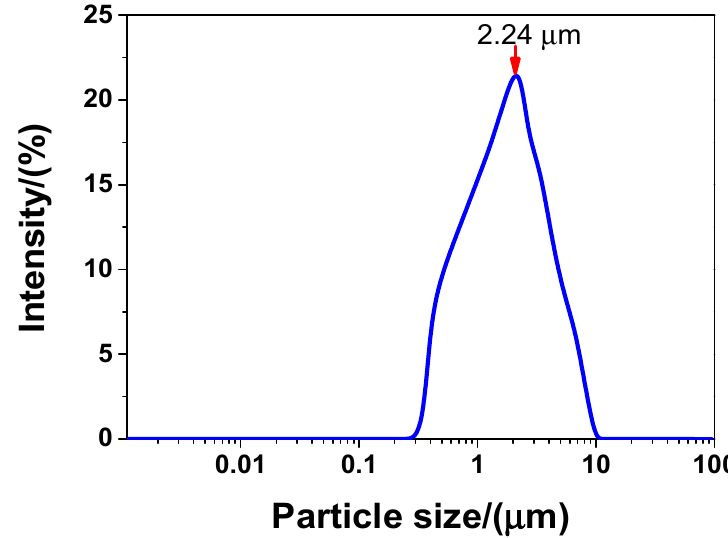
Figure 2. The particle size distribution of GO via dynamic light scattering test.